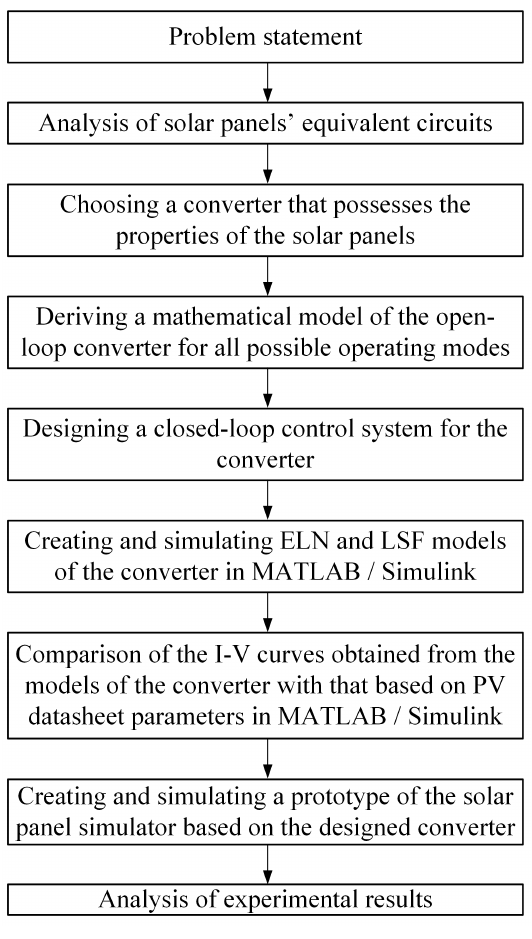
Figure 1. Concept of simulator designing.